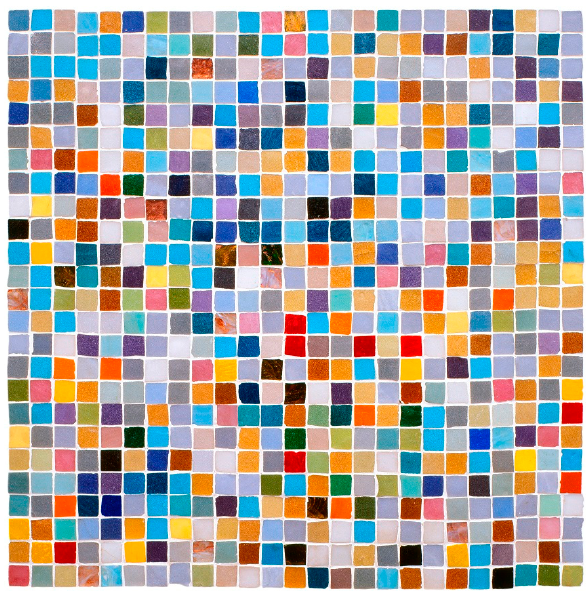
Figure 24. Anthony Hernandez, Waiting in Line #3 (1996), © Anthony Hernandez.